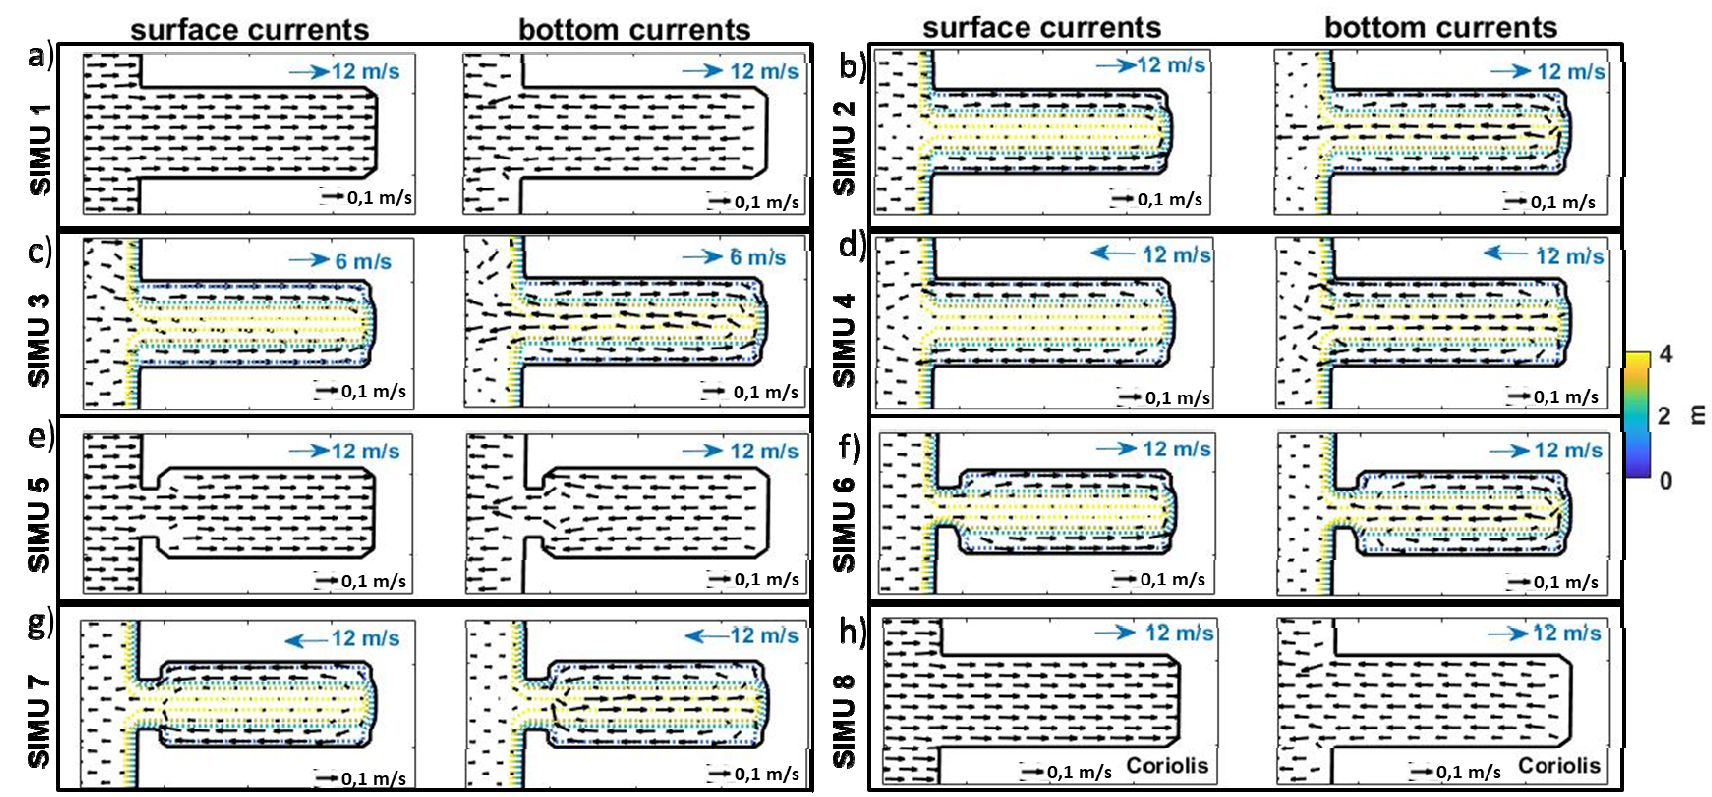
Figure 11. Representation of the simulations: ( a ) SIMU 1, surface and bottom; ( b ) SIMU 2, surface and bottom; ( c ) SIMU 3, surface and bottom; ( d ) SIMU 4, surface and bottom; ( e ) SIMU 5, surface and bottom; ( f ) SIMU 6, surface and bottom; ( g ) SIMU 7, surface and bottom; ( h ) SIMU 8, surface and bottom. Blue arrows show the wind direction with the intensity wind and black arrows show the water current intensity.